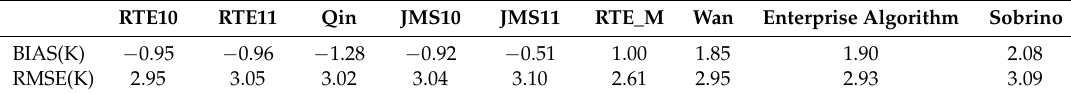
Table 6. Biases and RMSEs of LST retrieval with various methods.